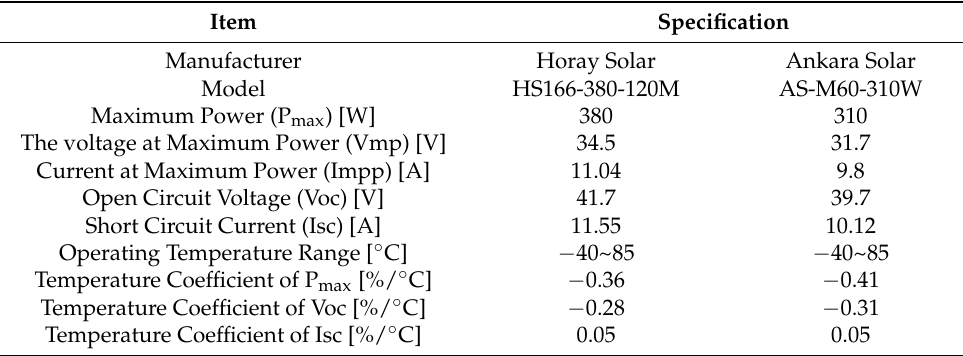
Table 3. Specification of the used PV modules at Standard Test